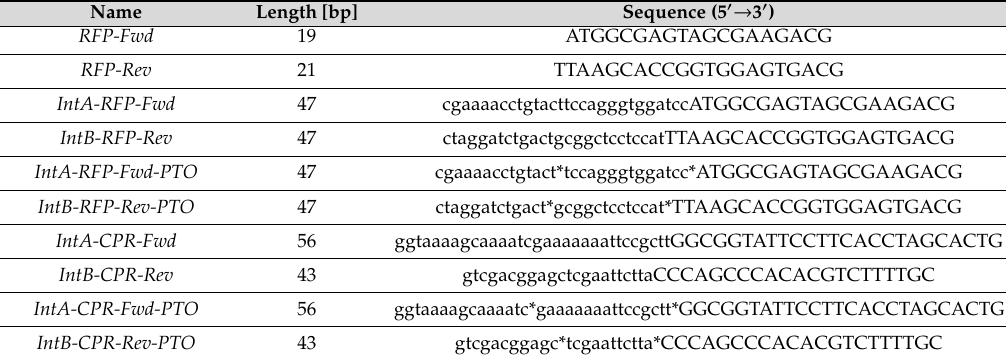
Table 1. Primers used in this study (* represents the location of PTO modification, and DNA sequence in lowercase denotes the region complementary to the recipient